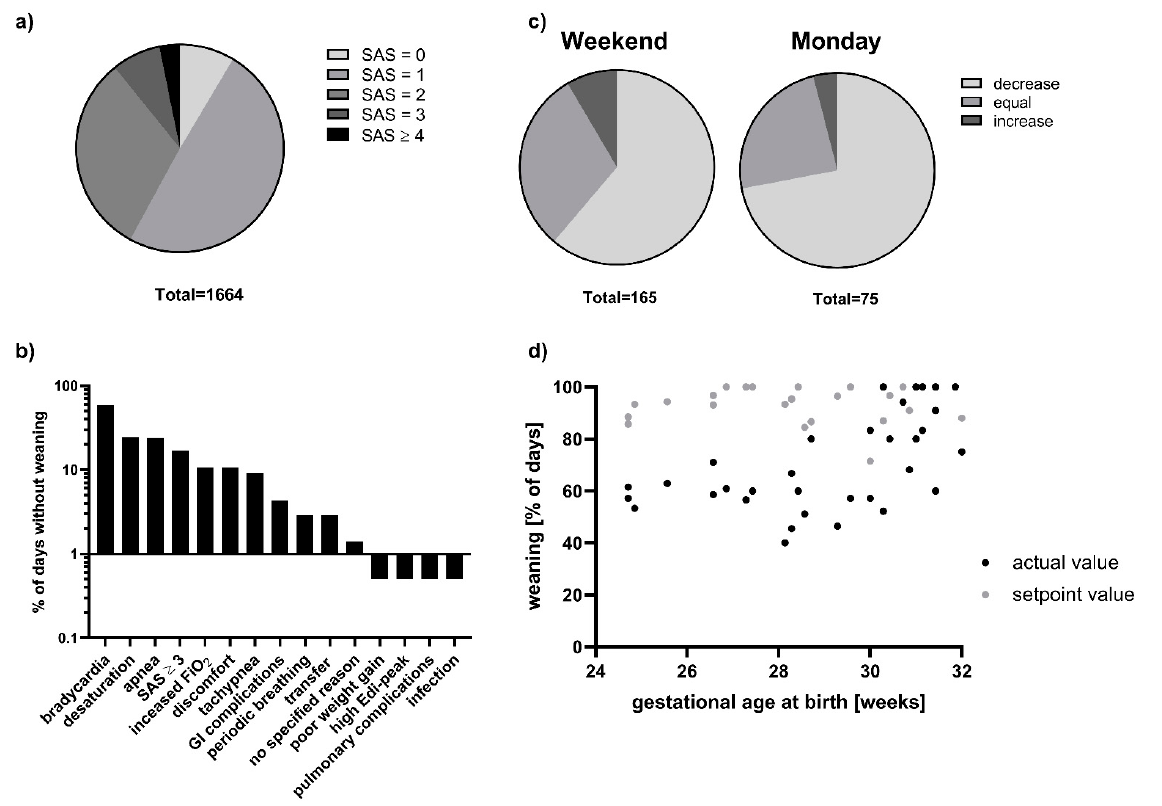
Figure 2. ( a ) SAS distribution in the prospective cohort. ( b ) Reasons for a decision against weaning. GI = gastrointestinal, Edi = electrical activity of the diaphragm. ( c ) Weaning on days of the weekend versus Mondays. ( d ) Actual and setpoint weaning per individual child. Table 2. NIV outcome parameters.